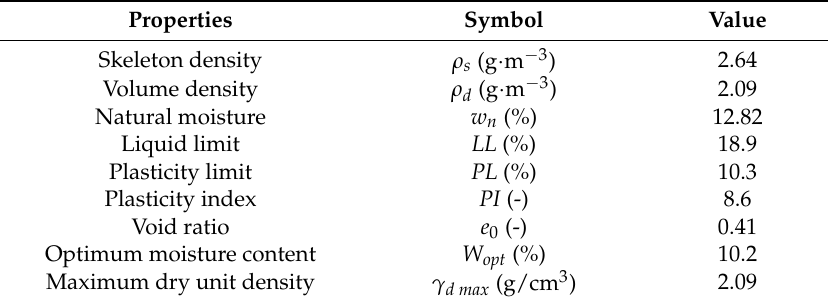
Table 1. Physical and mechanical properties of sandy clay in this